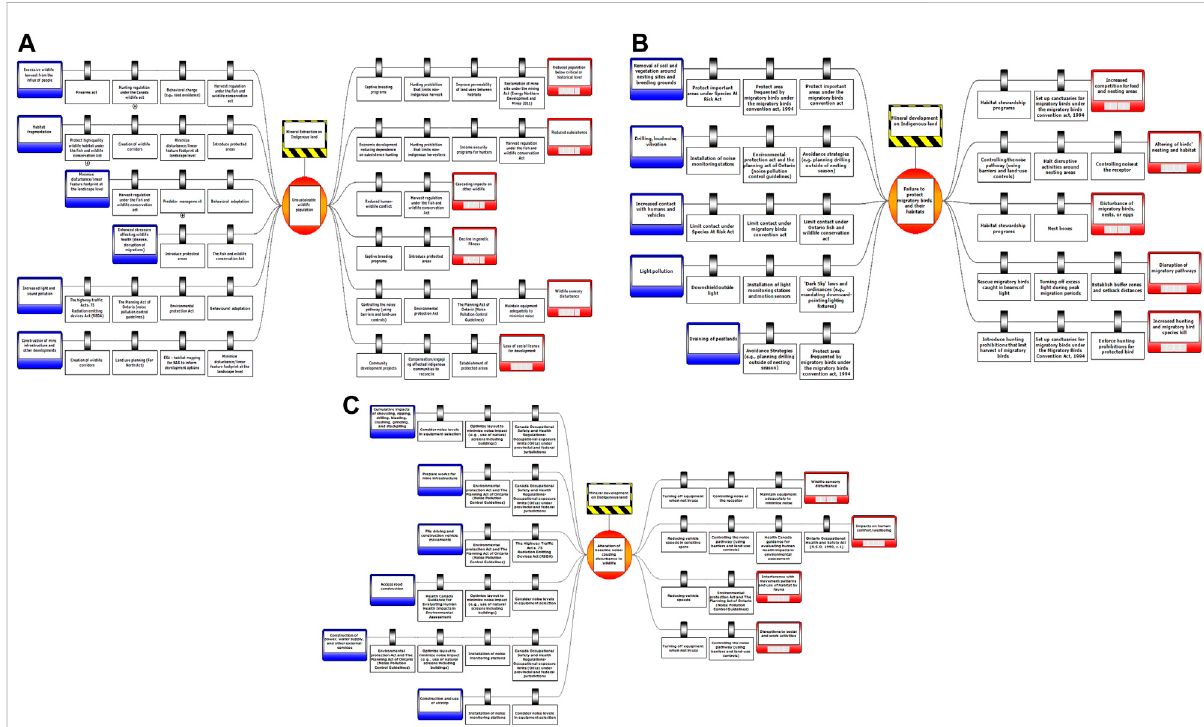
FIGURE 6 RiskAnalysisRelatedtoWildlifedisturbances. (A) Unsustainablewildlifepopulation (B) migratorybirdhabitatloss (C) alterationofbaselinenoise- causing disturbance to